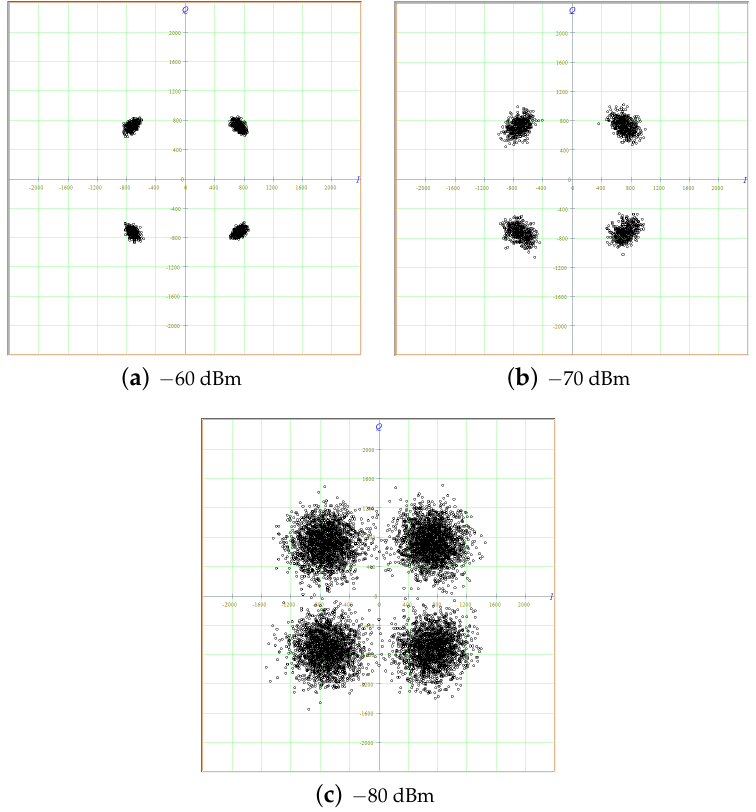
Figure 10. Quadrature phase shift keying (QPSK) test. Measured constellation in the I/Q plane for the whole receiver (Ka-band front-end, SDR and demodulator) at different input power levels. ( a ) P RX = − 60dBm; ( b ) P RX = − 70dBm; ( c ) P RX = − 80dBm. A QPSK signal at 40Msym/s, roll-off factor 0.25, is provided at the input. The receiver bandwidth is set to 56MHz. Considering the breadboard noise figure, a 12dB SNR is achieved in the − 80dBm